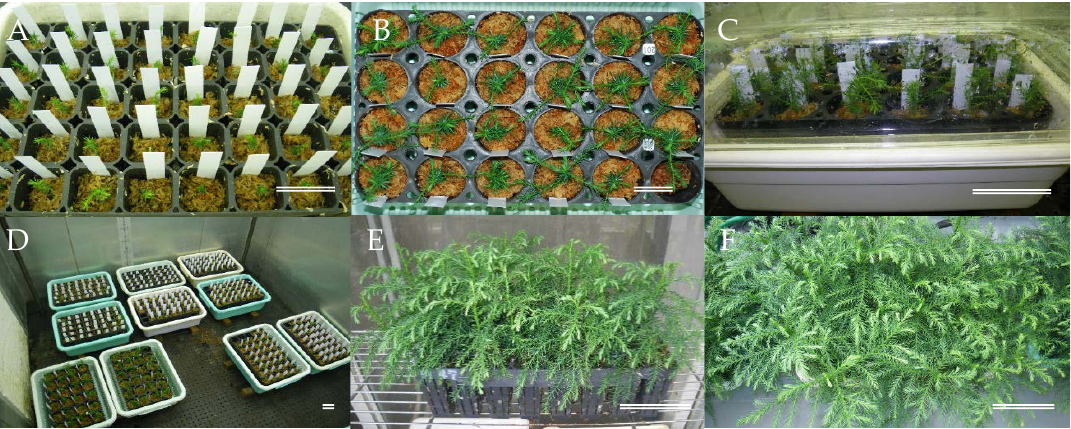
Figure 7. Acclimatization and ex vitro growth of somatic male sterile plants, ( A , B ) acclimatization in plant containers, ( C , D ) plastic boxes used for acclimatization, ( E , F ) acclimatized plants growing in a greenhouse before transplanting to the field. Bars ( A , B ) 5 cm, ( C – F ) 10 cm.